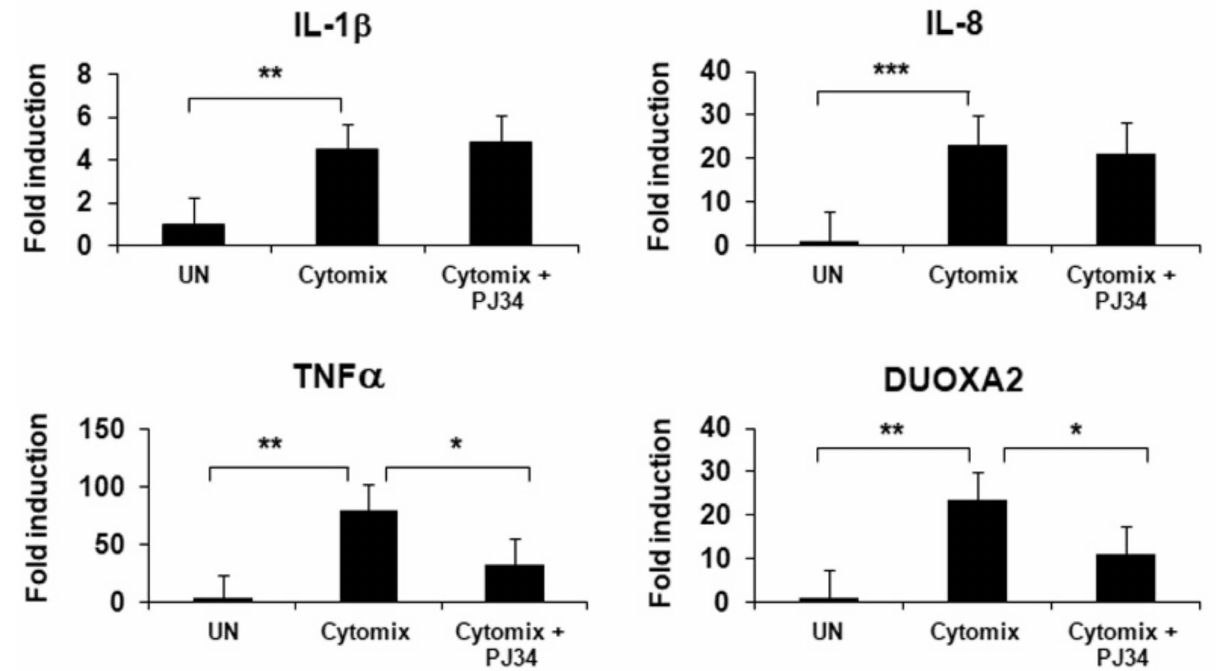
Figure 5. PJ34 treatment significantly improves inflammation and oxidative stress in HIOs. mRNA expression of pro-inflammatory cytokines IL-1 β , IL-8 and TNF α and oxidative stress marker DUOXA2 in HIOs exposed to cytomix or coexposed to cytomix and PJ34. Statistical analysis was performed using Mann–Whitney U test. * p < 0.05; ** p < 0.01; *** p <